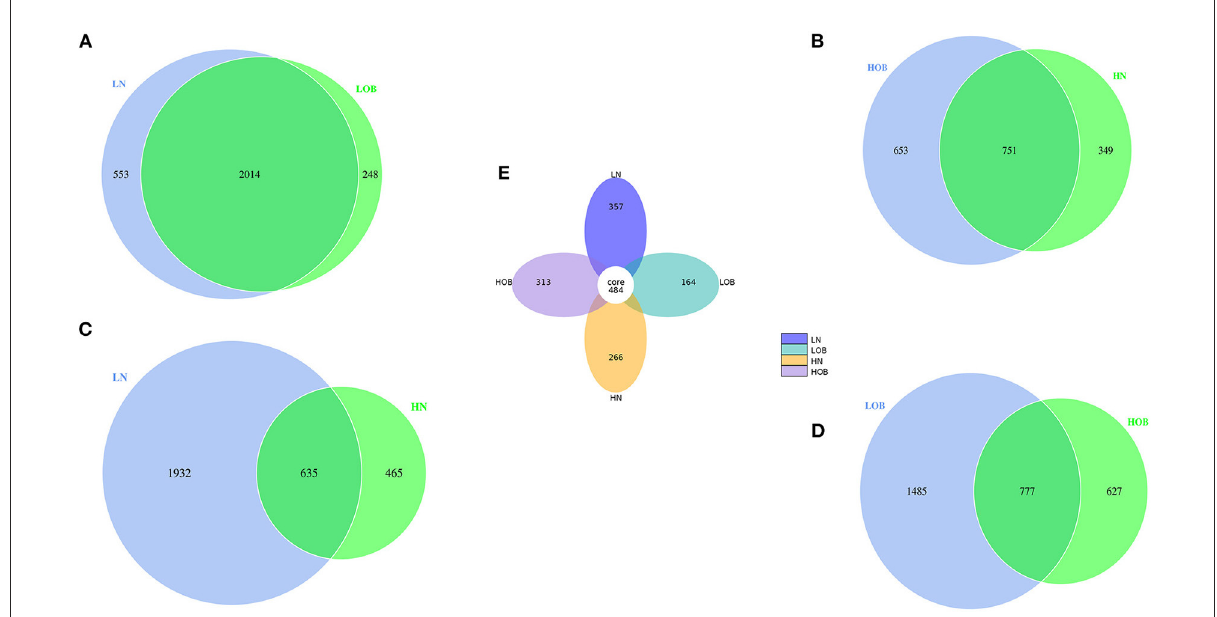
FIGURE2 (A–E) The comparison between the two groups was done using the Venn chart and multiple groups using petal chart. Different colored circles represent different groups. Overlapping parts of the circles represent common OTUs between two groups, none overlapping parts represent